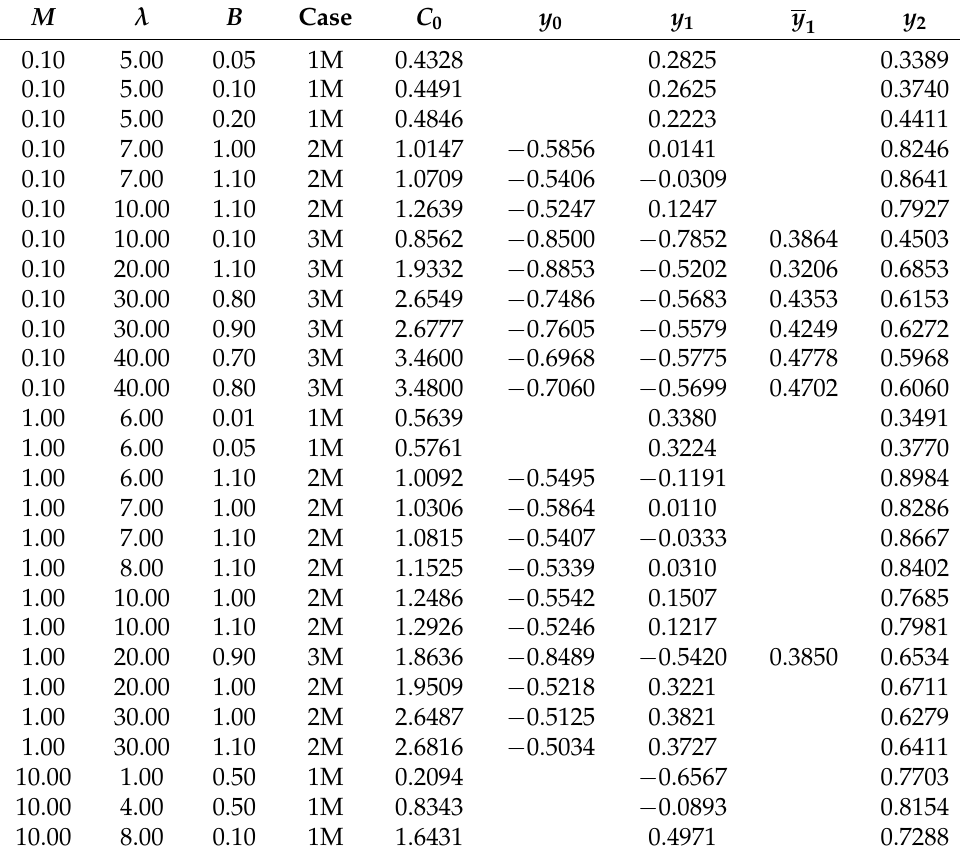
Table 2. Values of C 0 and of the boundaries of the plug regions when M , λ and B